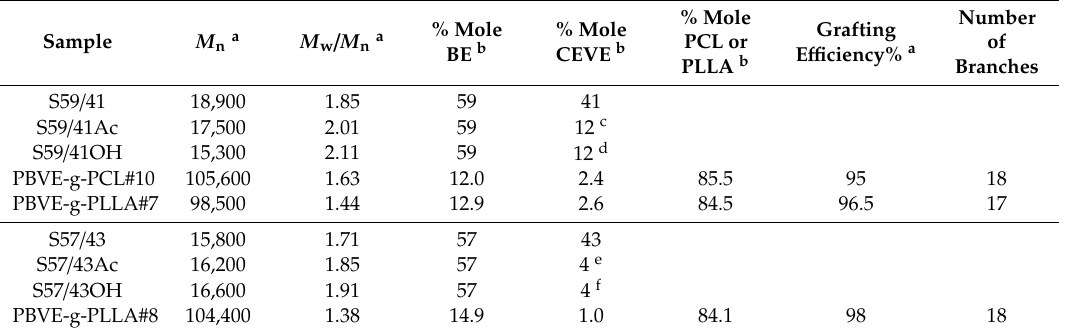
Table 7. Moecular characteristics of the graft copolymers prepared via the grafting “from” methodology.